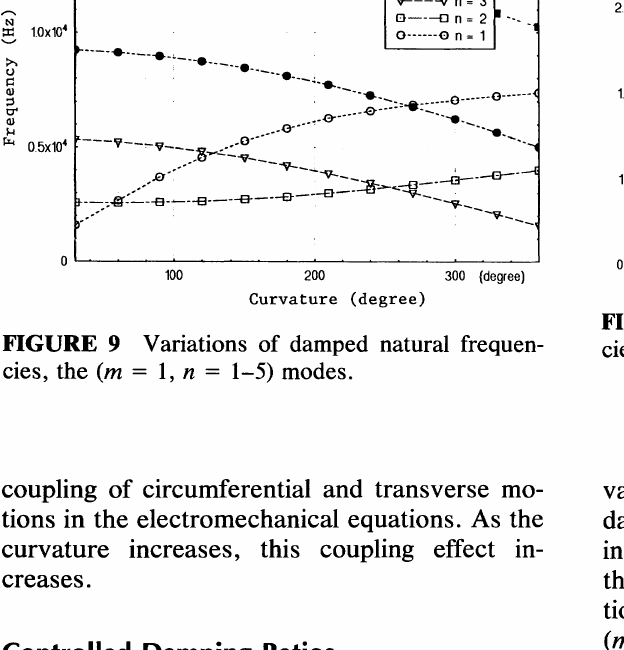
FIGURE 11 Variations of damped natural frequen cies, the (m = 3, n = 1-5)